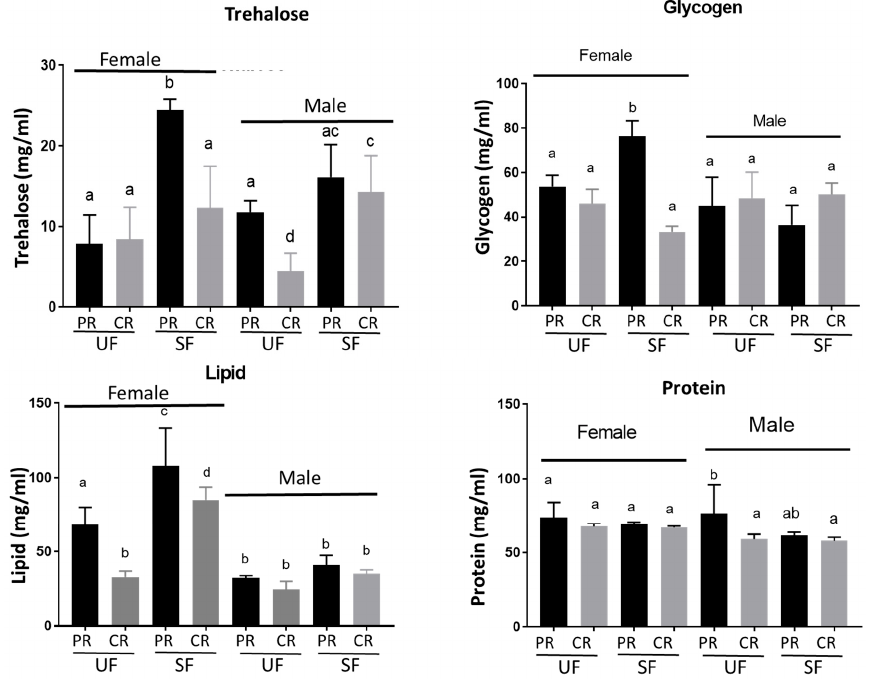
Figure 2. Effect of larval diets on adult trehalose, glycogen, lipid, and protein levels. Two 24 h old, unfed adult female and male mosquitoes per cohort from PR and CR groups were used to assess teneral nutrient reserves. Additional mosquitoes from the same cohort were also sugar-fed for 4 h and then processed 20 h later to assess differences in nutrient storage. Levels of glycogen, trehalose, lipids, and proteins were determined in females (first four vertical bars) and males (last four vertical bars) reared on PR (black bars) or CR (gray bars) diets (mean ± SD). One-way ANOVA followed by Tukey’s multiple comparison was used. Glycogen: F (D Fn , D Fd ): F (7, 40) = 22.45, p < 0.0001; Trehalose: F (7, 64) = 26.89, p < 0.0001; Lipids: F (7, 40) = 77.68, p < 0.0001. Protein: F (7, 40) = 4.419, p = 0.0010. Experiments were performed on four samples from each of three different cohorts. PR = protein-rich diet fed; CR = carbohydrate-rich diet fed; UF = unfed; SF = sugar-fed.